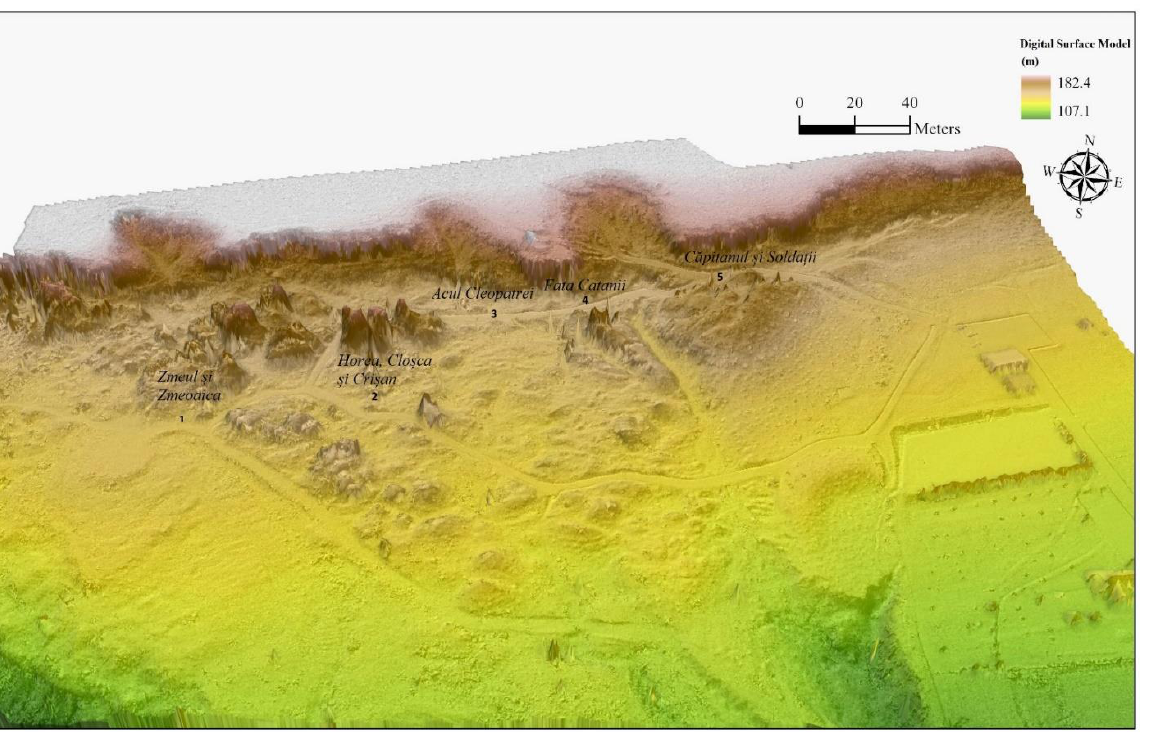
Figure 5. Slope Map of the Grădina Zmeilor geomorphosite (where: 1 — Zmeul and Zmeoaica, 2 — Horea, Cloșca and Crișan, 3— Acul Cleopatrei, 4 —Fata Cătanei, 5—Căpitanul and Soldații) .